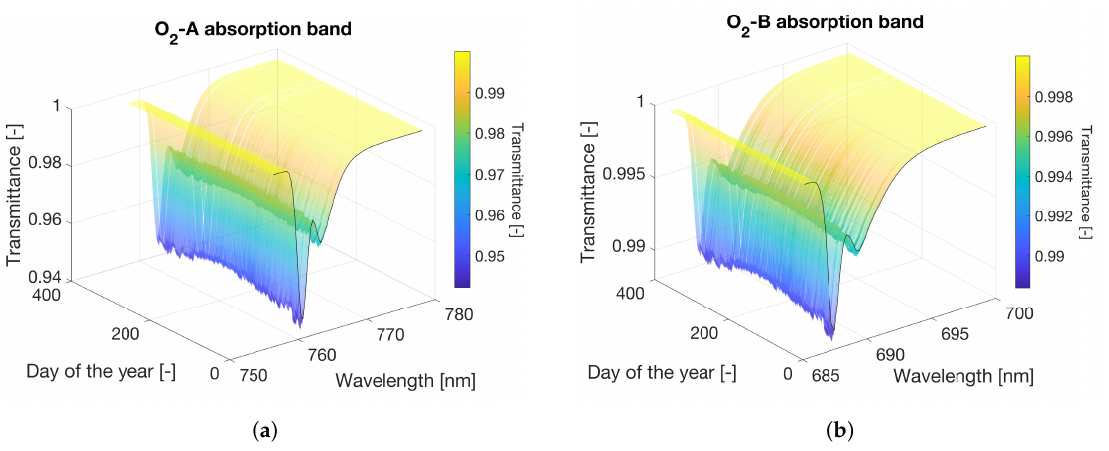
Figure 14. Spectral oxygen transmittance variation for the O 2 –A ( a ) and O 2 –B ( b ) absorption bands for the T and p conditions registered at 30 m tall tower at the Hyytiälä Forest Field Station in Finland.